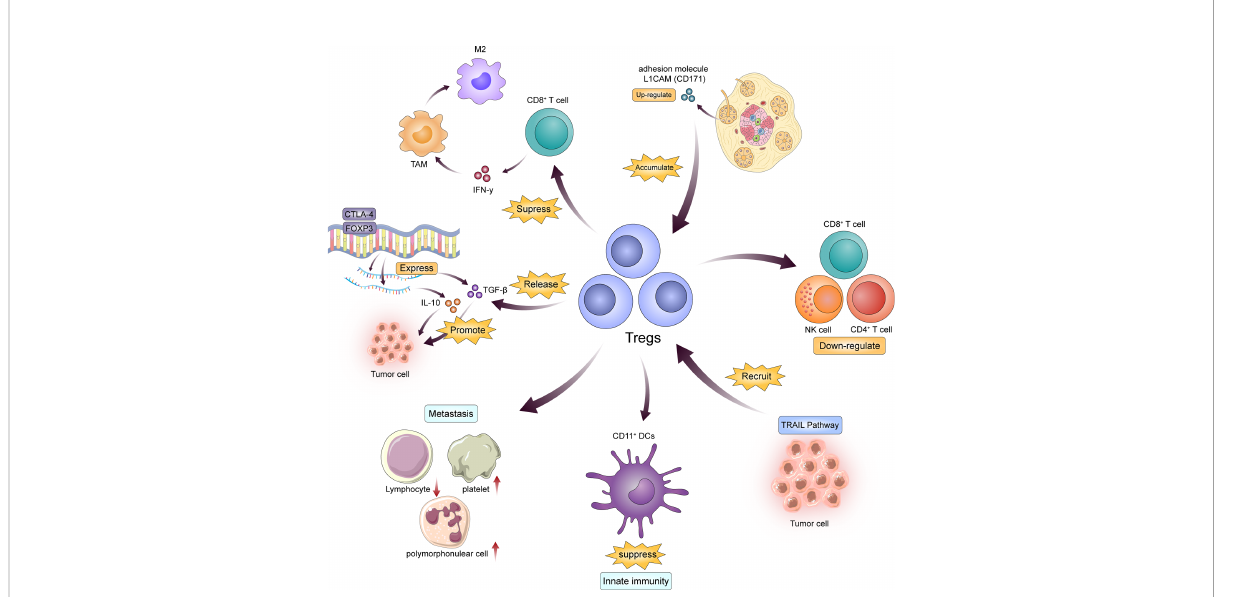
FIGURE 1 Tregs are the key to immunosuppression in the progression of PDAC. On the one hand, PDAC cells recruit Tregs in a variety of ways; on the other hand, Tregs change the blood environment and maintain the activity of M2-TAMS and DCs by releasing cytokines such as TGF and IL, thus achieving the effect of inhibiting effector T